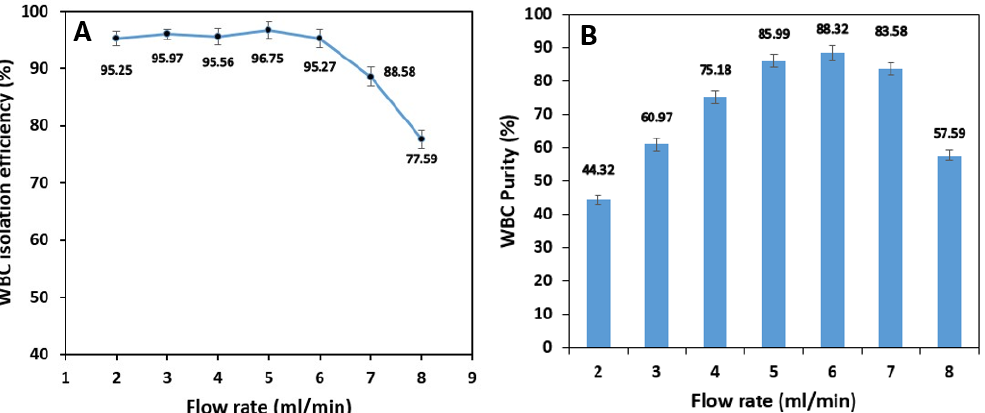
Figure 11. The effect of the sample inlet flow rate on WBC: ( A ) isolation efficiency, and ( B ) purity for a 1% blood hematocrit sample. The WBC isolation efficiency experiences a massive drop in higher flow rates due to the existence of high-strength dean vortices which force the WBCs to migrate to the outer microchannel wall. The outlet samples are the purest with flow rates of 4, 5, and 6 mL/min. The higher the removing ratio of RBCs and platelets, the higher WBC purity.